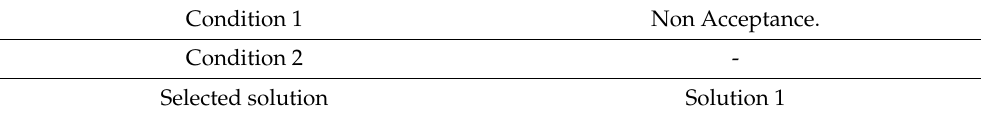
Table 8. Result of the conditions